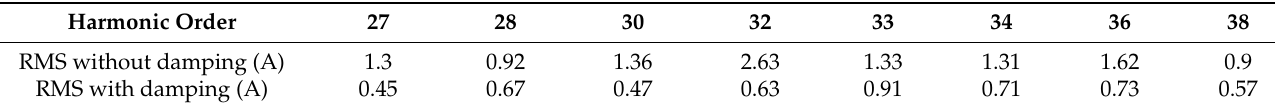
Figure 17. Experimental waveforms of virtual damping (CH1—SAPF current before LCL filter; CH2—SAPF current after LCL filter; CH3—grid current) ( a ) without virtual damping; ( b ) with vir- Table 1. Performance of shunt virtual damping tual damping. Table 1. Performance of shunt virtual damping control.